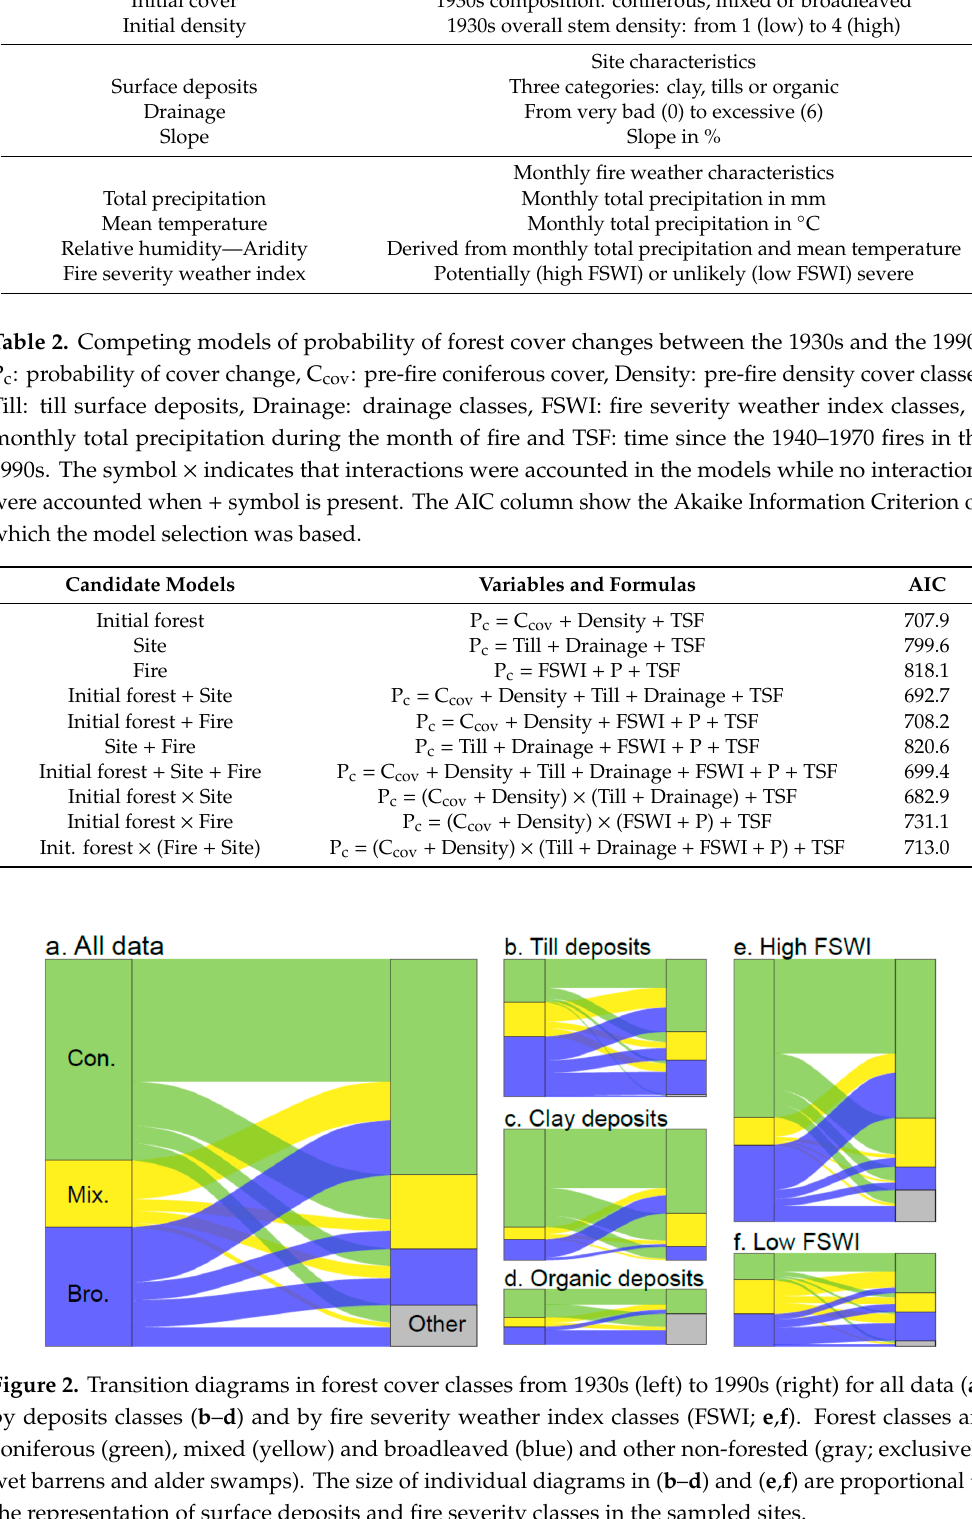
Figure 3. Results of overall probability of cover changes modeling. The plots show the predicted values and 95% confidence intervals obtained with the selected linear mixed model that account for initial forest cover, sites characteristics and their interactions (R 2fixed = 0.30; R 2fixed+random = 0.43). Black and white plots show single effects while colored plots show interaction effects. Only significant ( p < 0.05) effects and interactions are shown (except for forest initial density that had a significant but very weak negative effect). Drainage classes range from bad (0) to good (4), and initial tree cover density ranges from low (1; 0–25%) to high (75–100%). Probability of change from broadleaved/mixed to coniferous cover was associated with both fire and site characteristics (Figure 4). The model that accounted for FSWI, monthly total precipitation during the month of fire, drainage and surface deposits without interactions was retained with the smallest AIC. This model explained 49% of the variance in the probability of a 1930s broadleaved/mixed cover to change to coniferous when considering both random and fixed effects, while 19% of the variance when only considering fixed effects. Fire severity and drainage had a significant positive effect, which means that a 1930s broadleaved/mixed cover had higher probability to change to coniferous after a potentially severe fire and on well-drained sites. Conversely, till